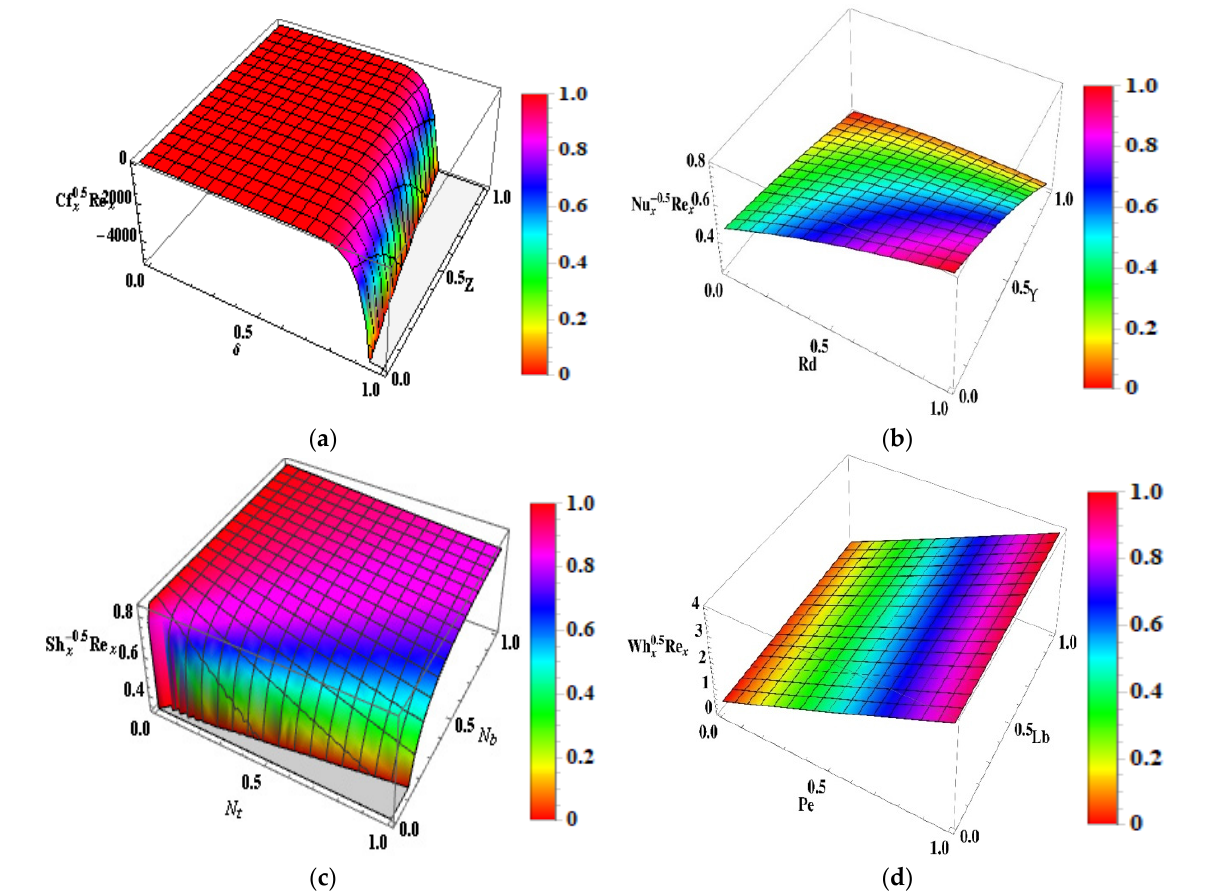
Figure 10. ( a – d ) 3D graph ( a ) Skin friction for δ and Z ( b ) Nusselt number for Rd and Υ . ( c ) Sherwood number for Nt and Nb ( d ) Motile density for Pe and Lb .